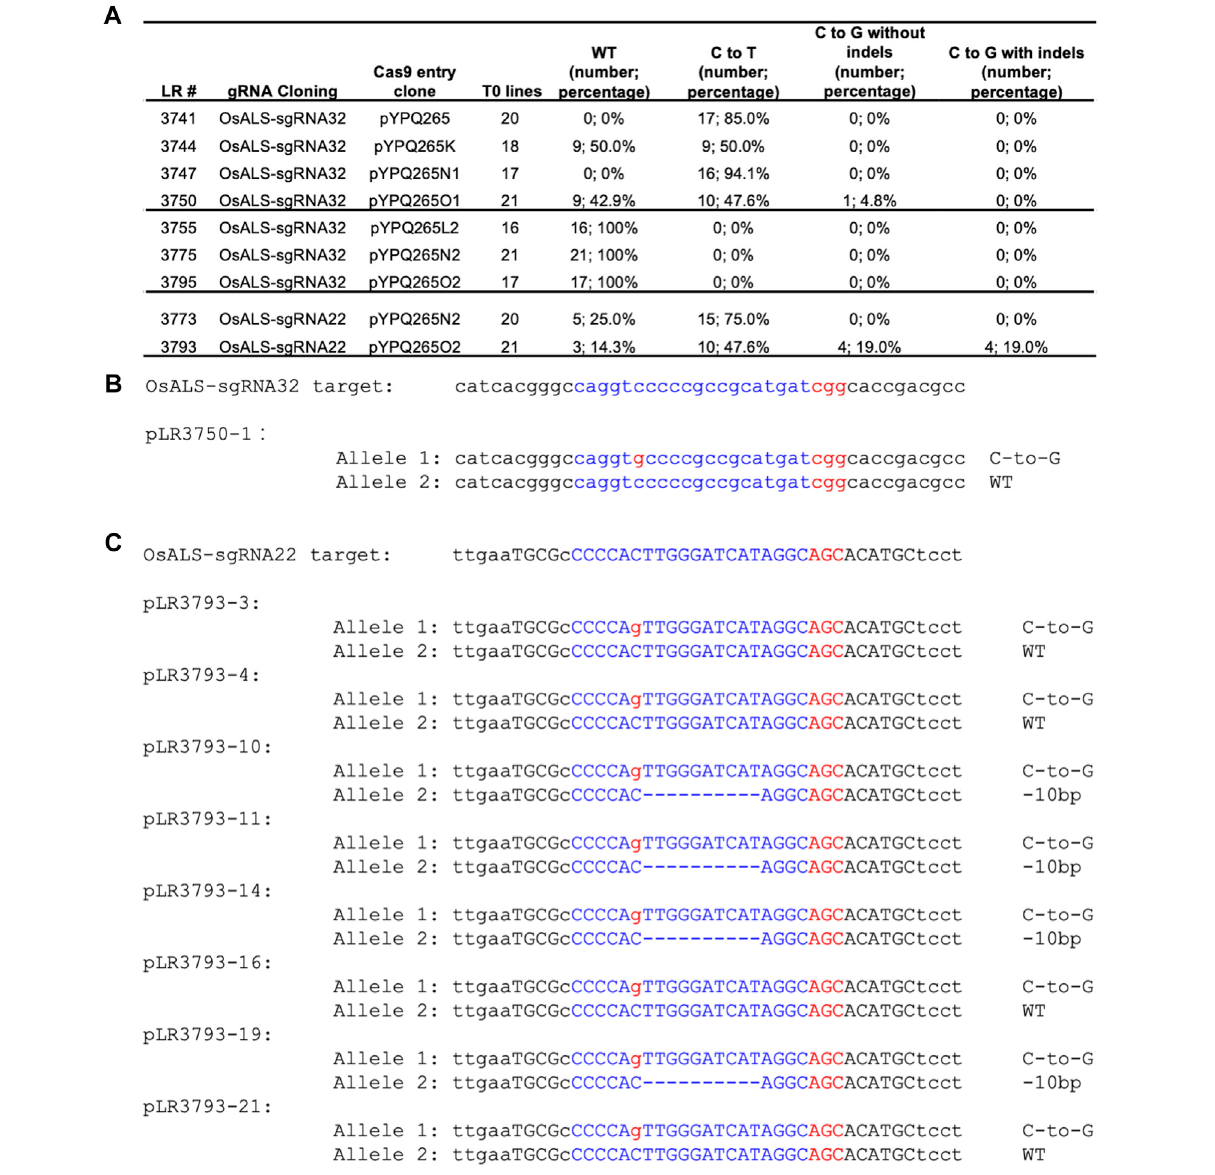
FIGURE 4 | C-to-G base editing in stable rice lines (A) Summary of editing outcomes in transgenic T0 lines by different base editors. In brackets, number corresponds to the number of T0 lines having de fi ned editing outcomes. (B) An example T0 line with a pure (i.e., monoallelic and non-chimeric). C-to-G editing allele (C) ExampleT0lines withpure(i.e.,monoallelicandnon-chimeric).C-to-Geditingalleles.Thetarget sequences arehighlightedinblue. ThePAMsequencesand theC-to-G changes are highlighted in